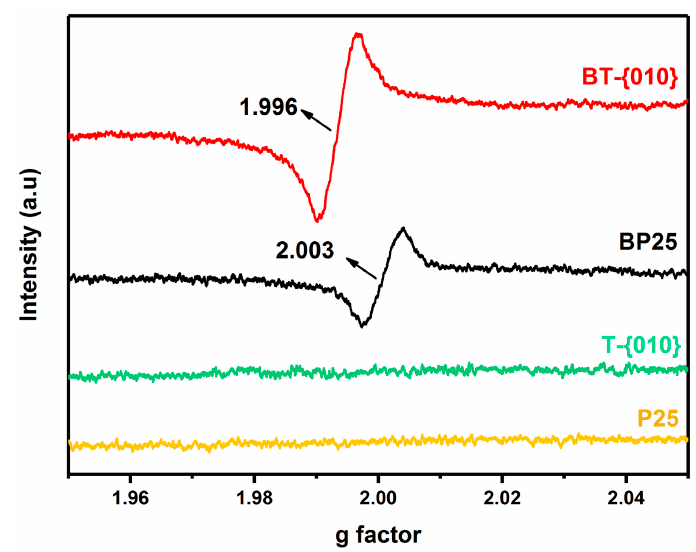
Figure 7. EPR spectra for P25, T-{010}, BP25 and BT-{010}.